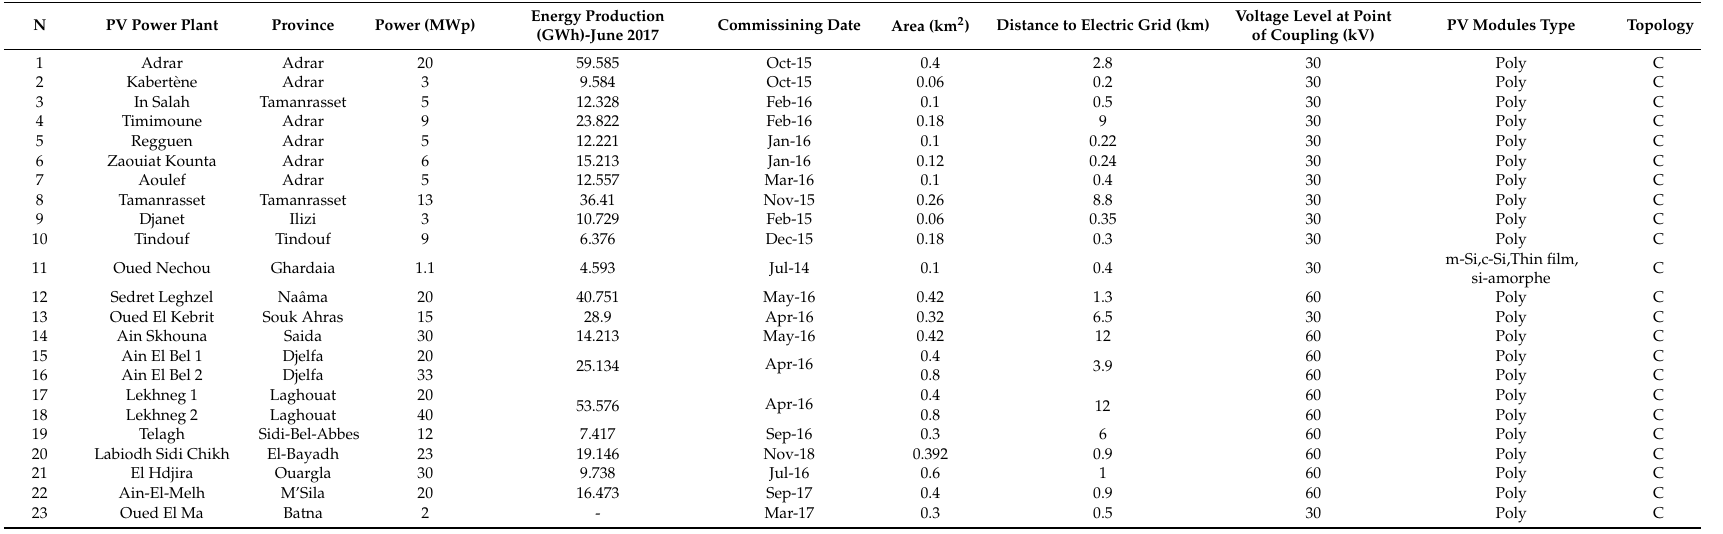
Table 4. Photovoltaic power plants installed in